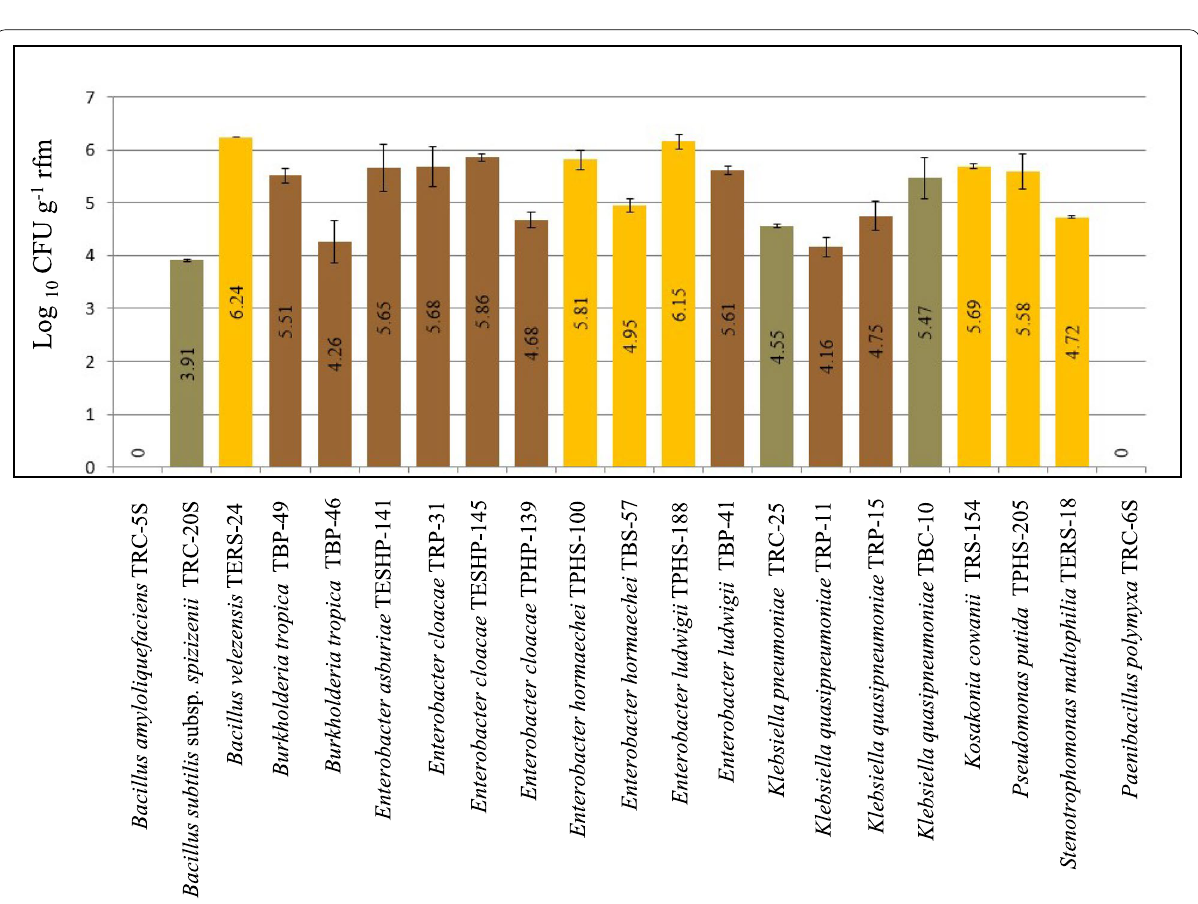
Fig. 4 CFU counts of rifampicin‑resistant PGPR isolates colonizing tomato root 1 month after